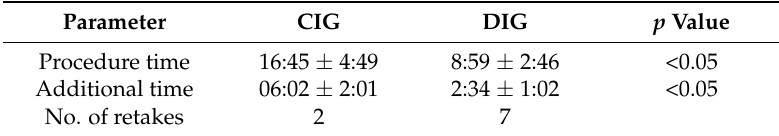
Table 2. Time needed (minutes) for conventional and digital bone loss values (mean ± SD) for tilted and upright implants of both groups (CIG = conventional impression group; DIG = digital impression group).